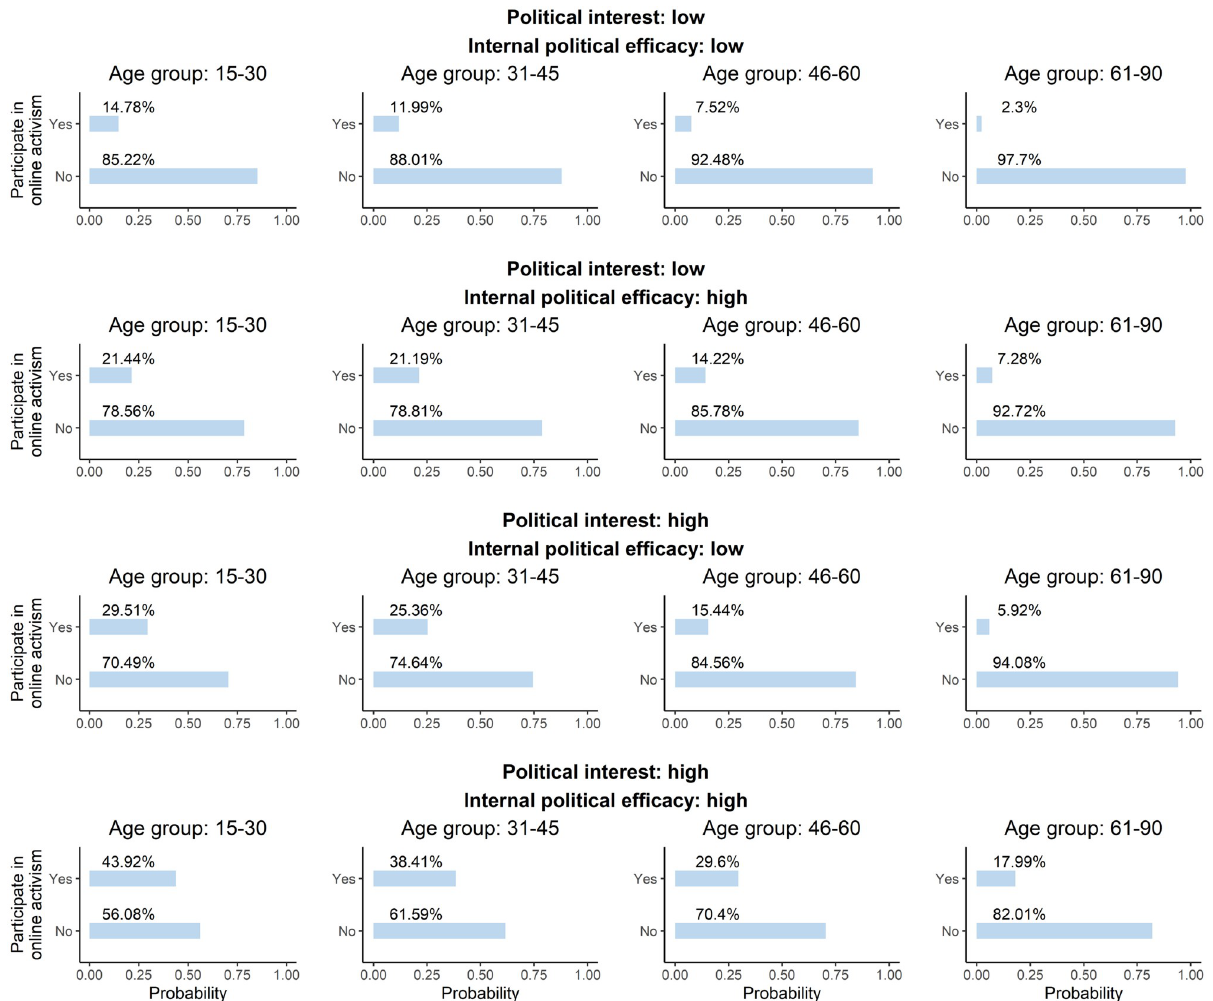
Fig 5. Probability distribution table of participation in online activism. Source : ESS 2018 [35]. N = 27 379 individuals in 19 countries. Notes : Bayesian parameter estimation, conditional on the acquired structure of the network, was applied to analyse the data. Entities are the probability of participation in online activism in